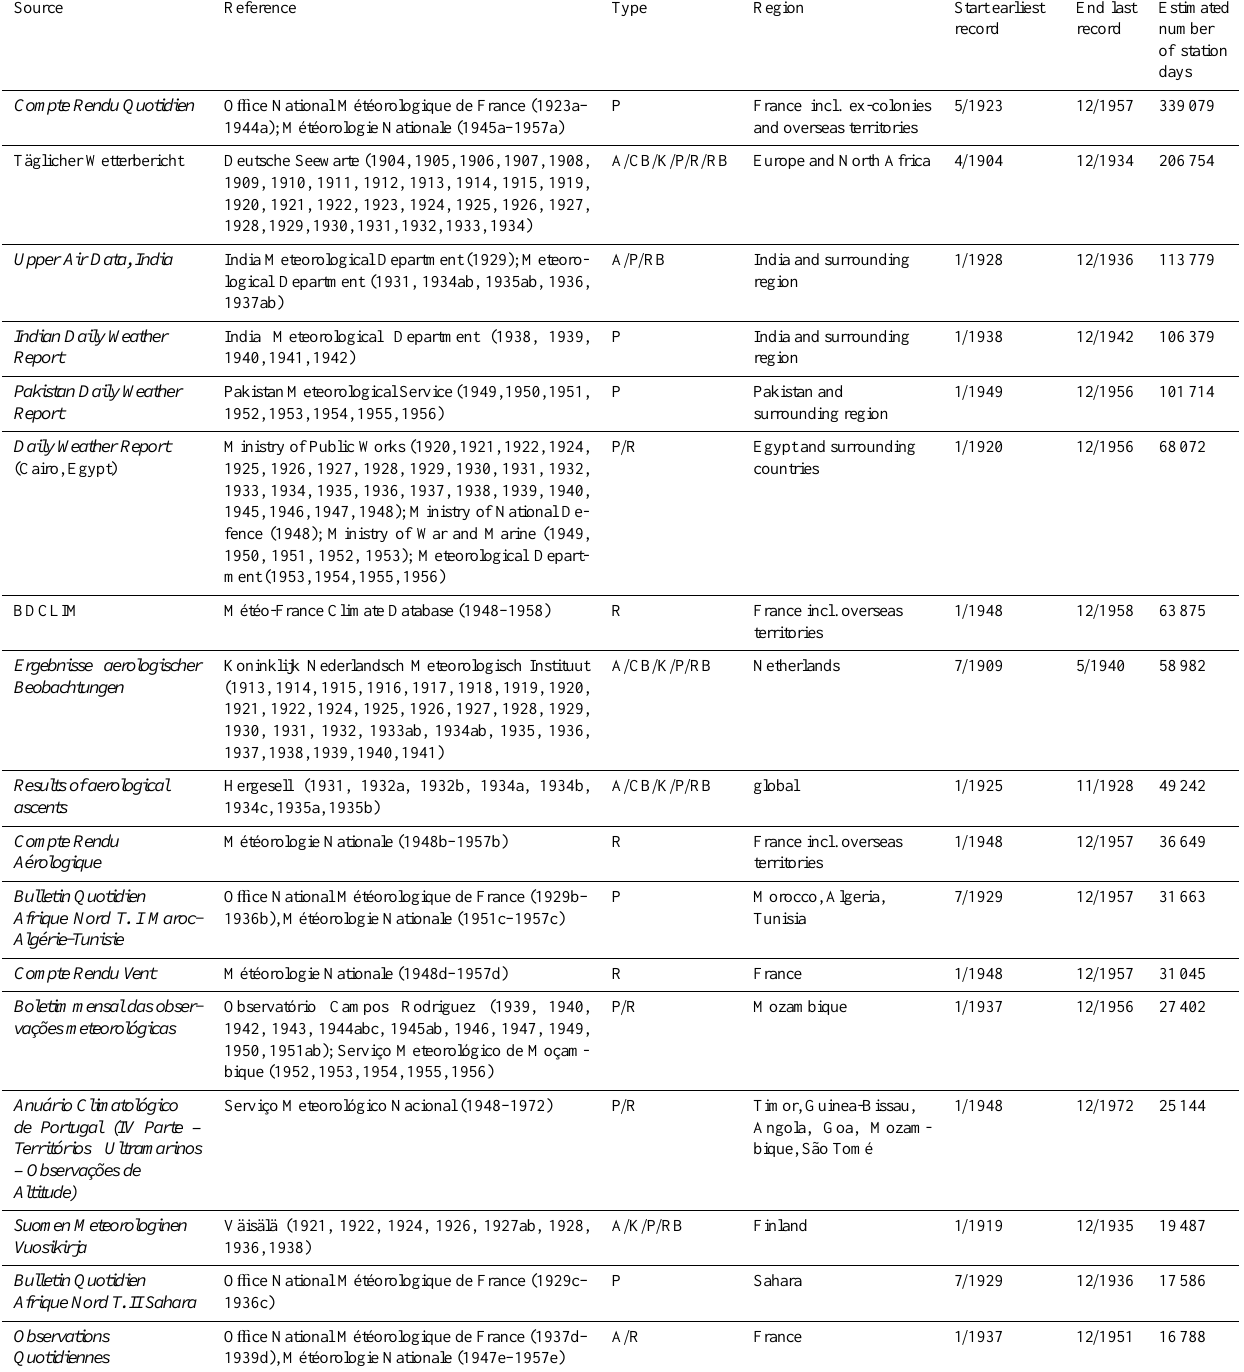
Table 3. The largest single inventoried ERA-CLIM sources of fixed station upper-air data ( > 15000 station days). In the “type” column, A stands for aircraft, CB for captive balloon, K for kite, P for pilot balloon, R for radiosonde, and RB for registering